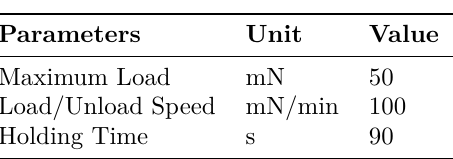
Table 2. Instrumented test parameters.